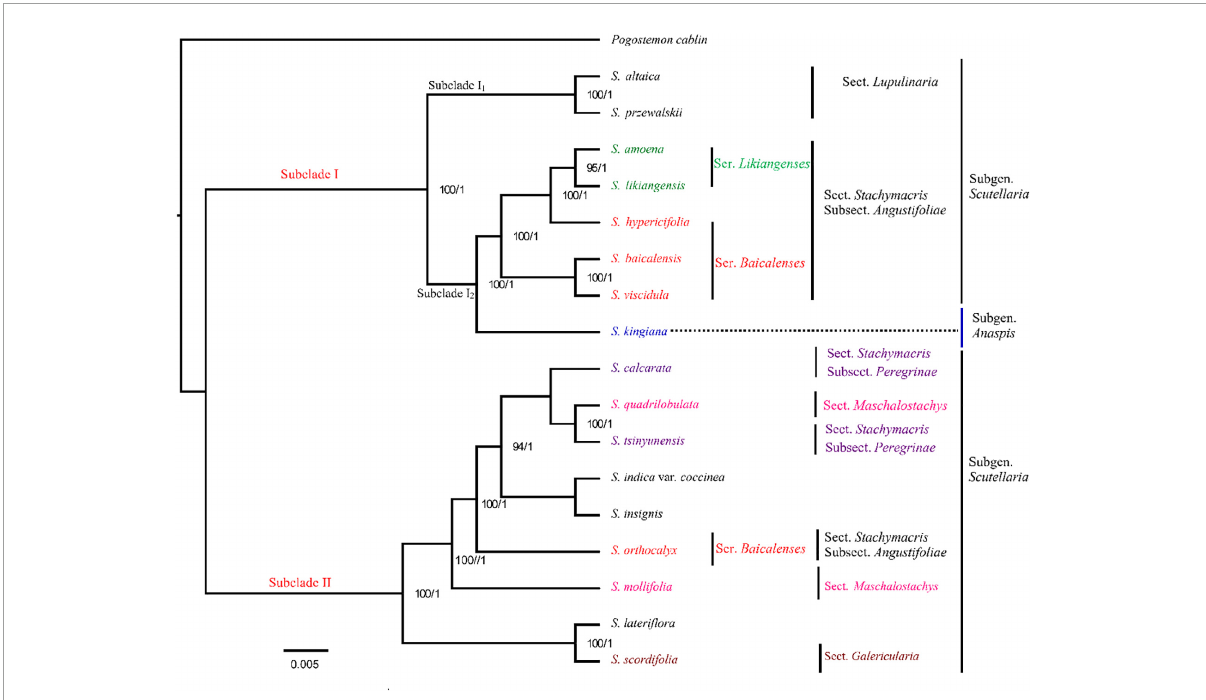
FIGURE2 Phylogenetic relationships of the 17 species by maximum likelihood (ML) and Bayesian inference (BI) analyses ( Pogostemon cablin as an outgroup) based on alignments of complete chloroplast genomes. The numbers above nodes are supported values with ML bootstrap values on the left and Bayesian posterior probability (PP) values on the